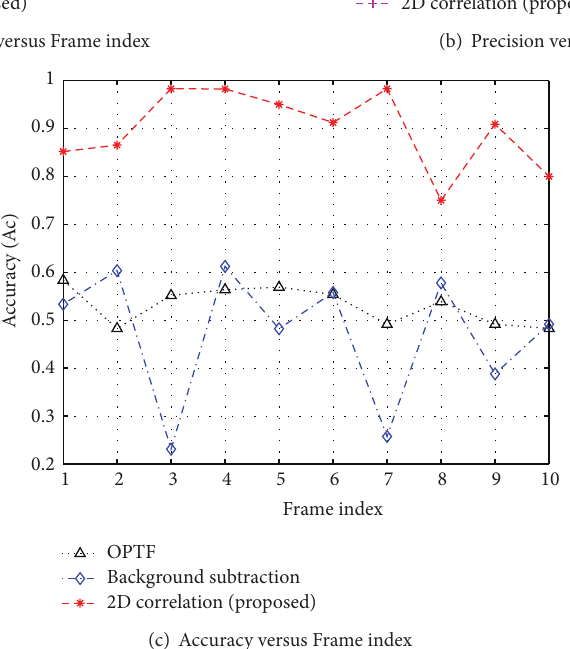
Figure 6: Comparative analysis of frame based surveillance metrics on “cat video.bin” video sequence.